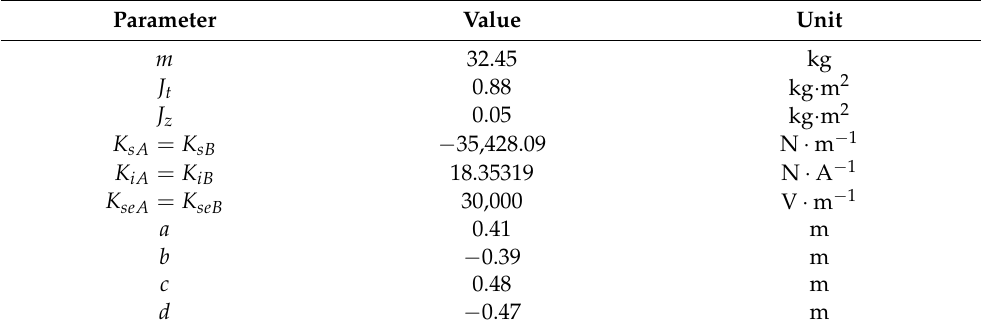
Table 1. Simulation